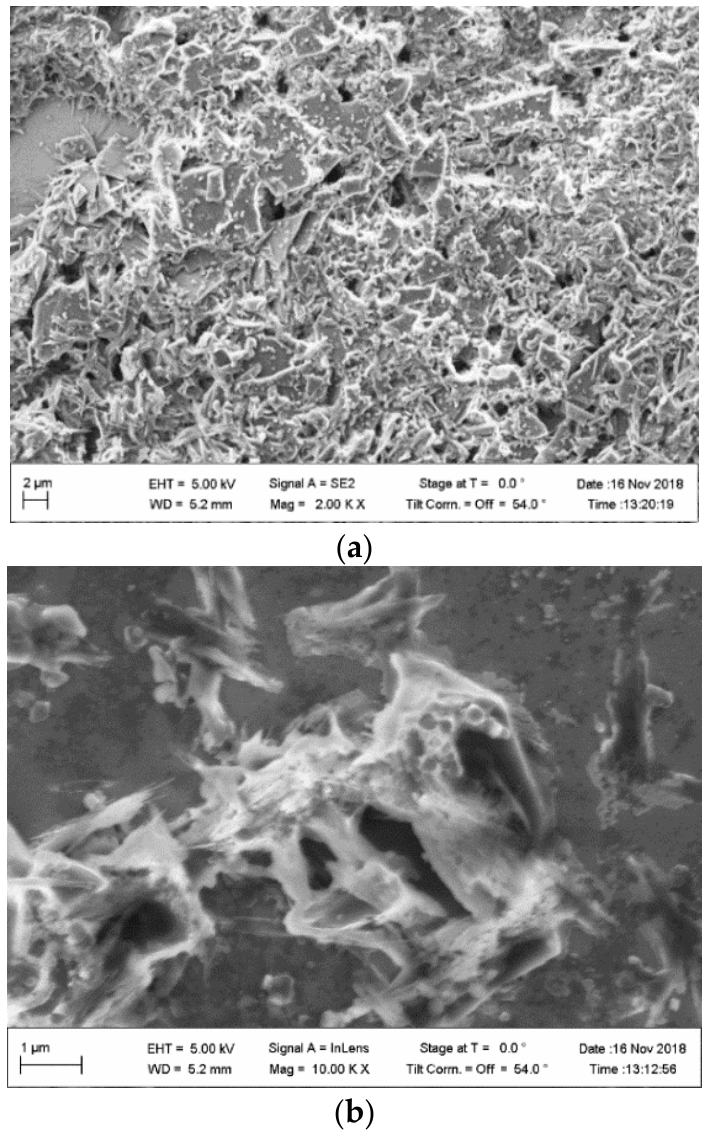
Figure 7. SEM image of Na-Pery ( a ) at 2 kx and ( b ) at 10 kx.